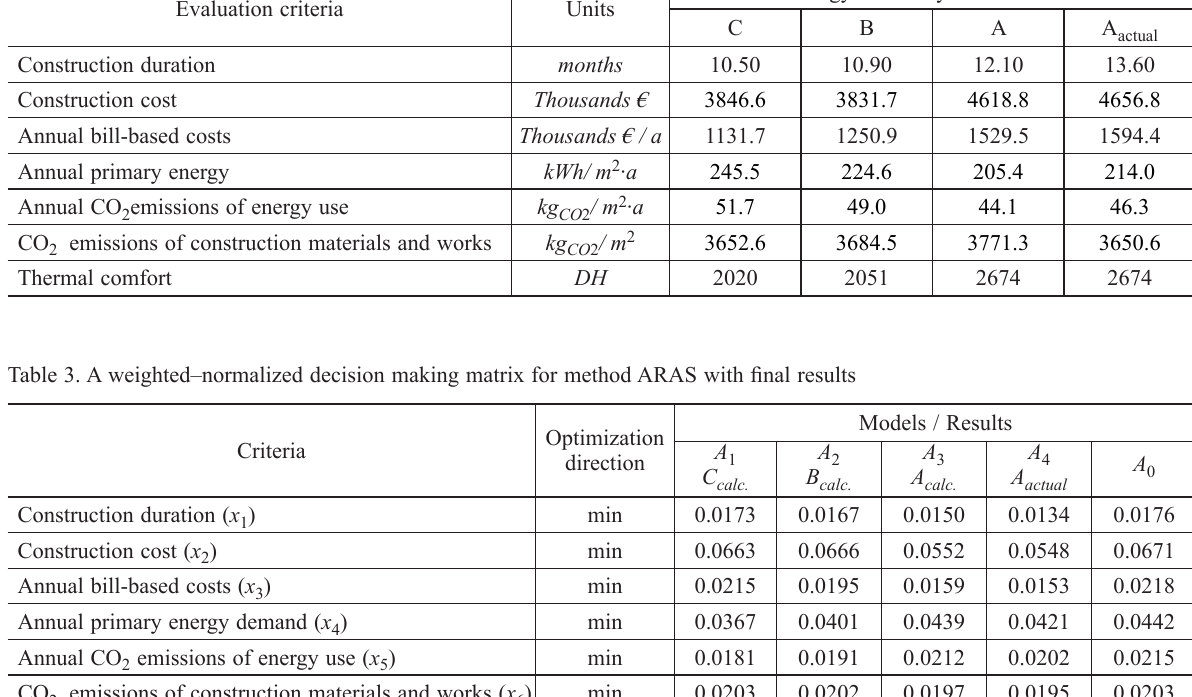
Table 2. Initial indicators for building performance evaluation according to the energy efficiency classes Evaluation criteria